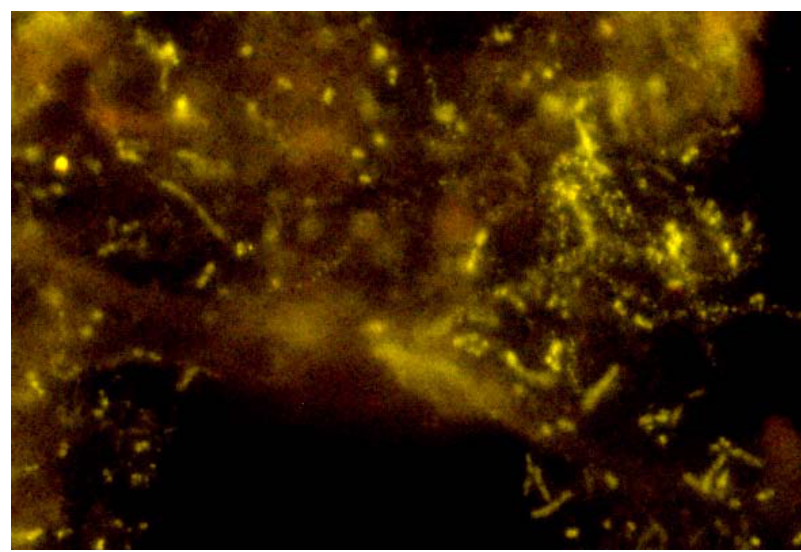
Figure 10. Specific identification of whole fixed bacterial cells with fluorescent oligonucleotide probes (FISH)—SS + kraft lignin/silica combination (400× magnification).